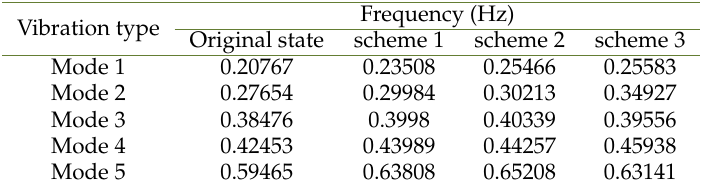
Table 4. The coMParison of vibration frequency